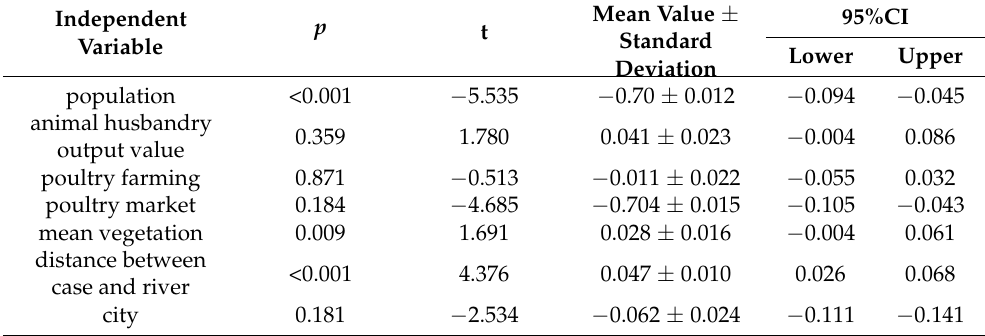
Table 2. Correlation analysis results.